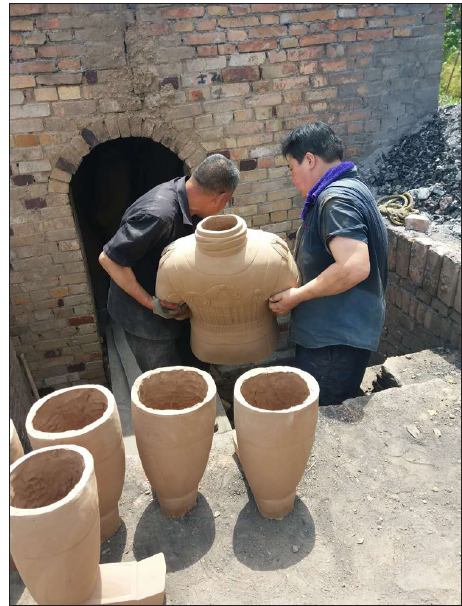
Figure 2: Weidong Zhou (right) supervising firing in the kiln (Photo Weidong Zhou).